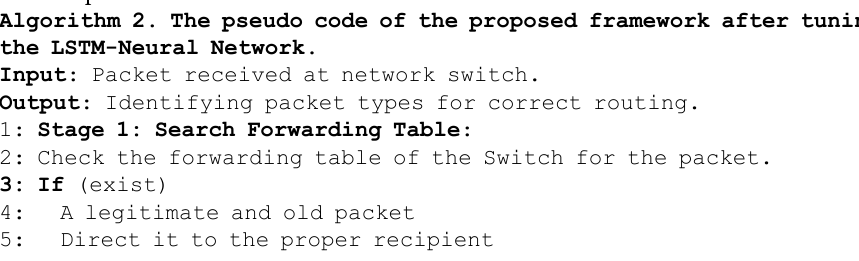
Algorithm 2 and the logic diagram of the received packet flow status in Fig 5 clarify the clas- sification process in detail. Algorithm 2. The pseudo code of the proposed framework after tuning the LSTM-Neural Network .